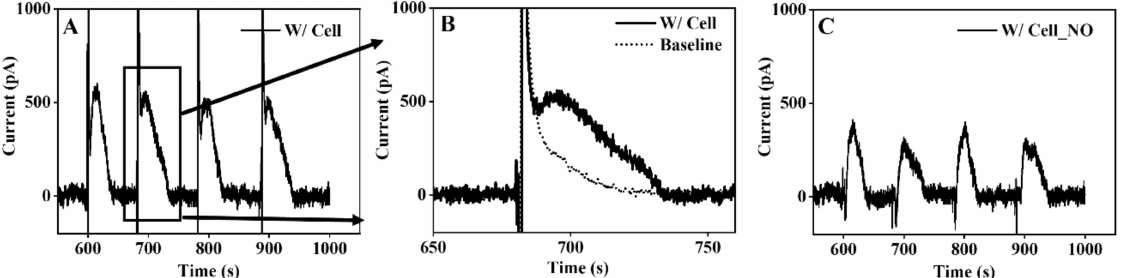
Figure 6. ( A ) Amperometry recording in cultured endothelial cells with electrical stimulations applied. ( B ) An enlarged current response curve showing the increased current after the stimulation artifact. ( C ) Baseline subtracted signal. The applied potential is +0.9 V vs.